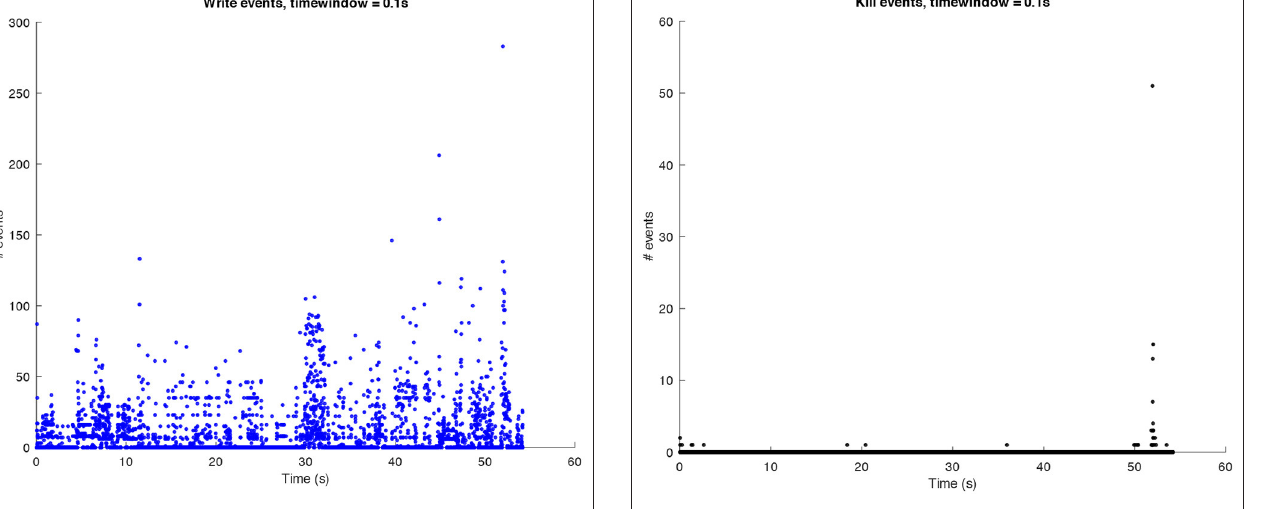
FIGURE 3 | Amount of kill events per window of time (0.1 s ) in a shutdown